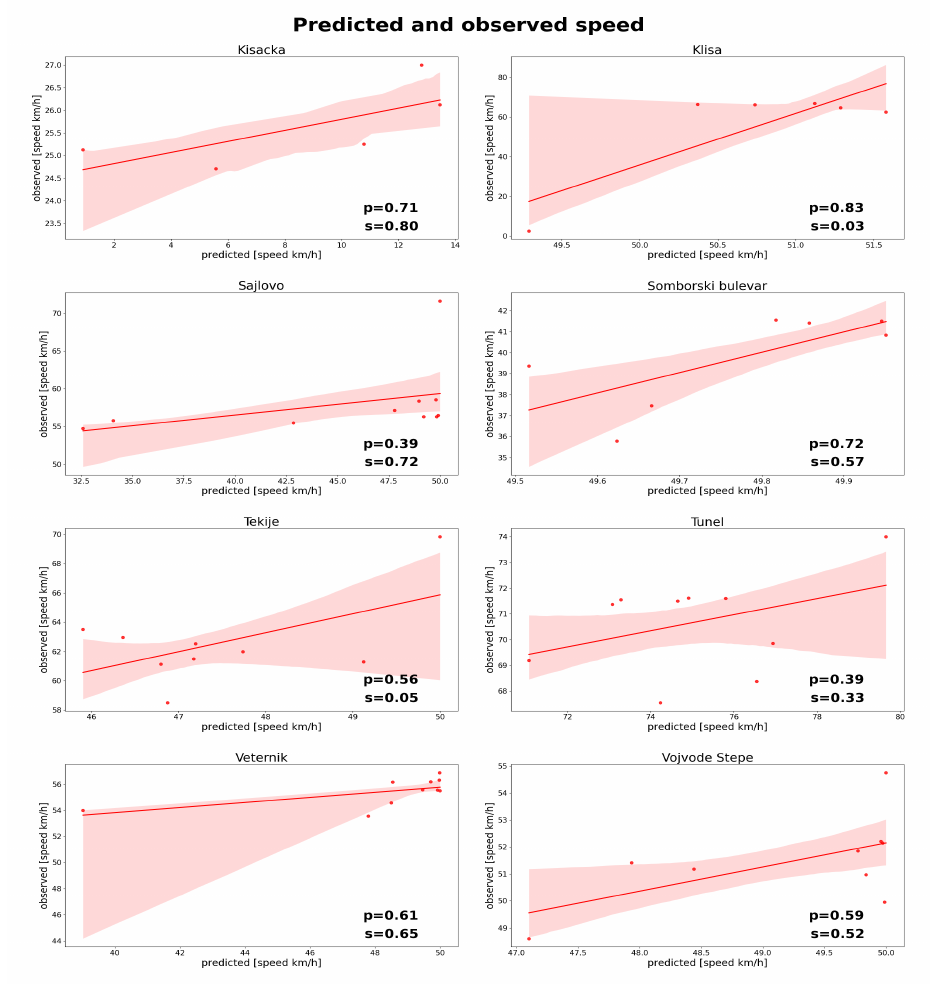
Figure A4. Validation—Pearson’s (p) and Spearman’s (s) correlation coefficients between predicted and observed speed in automatic vehicle counters data set. The selected day from automatic vehicle counters data set was 3 December 2019. Please note: the axes are not in the same scale to emphasize the captured